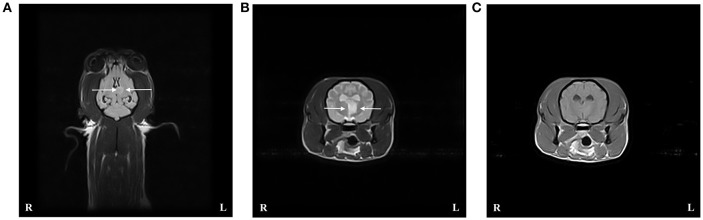
Case 1 T2-weighted (T2W) FLAIR dorsal image of the brain (A), and T2W (B) and T1-weighted (T1W) post contrast (C) transverse images at the level of the thalamus revealed an intra-axial well demarcated lesion to the left of the midline consistent with a dorsal extensive thalamic infract. The lesion (indicated by arrows) is hyperintense compared to normal gray matter on T2W sequences and hypo- to isointense on T1W sequences.